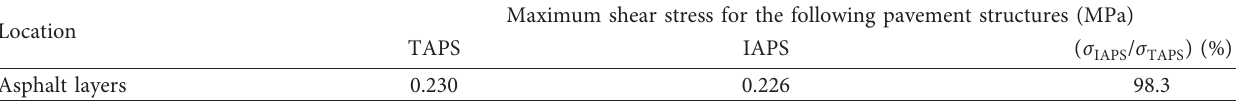
Table 3: The calculated maximum shear stress of the two asphalt pavement structures.